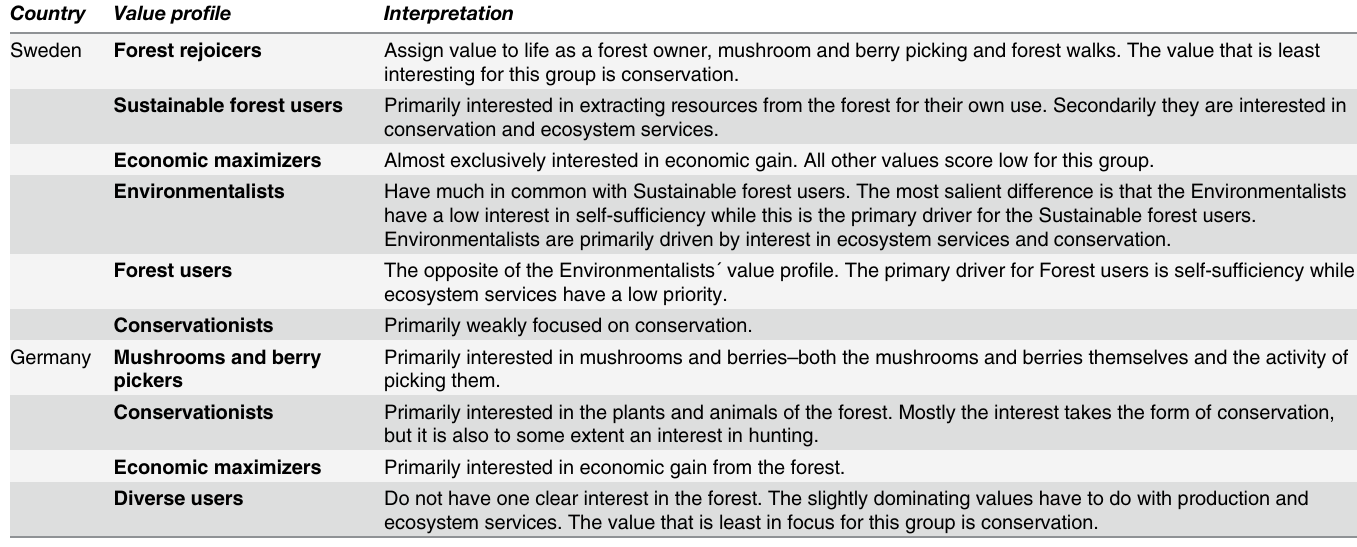
Table 2. Value profile interpretations per